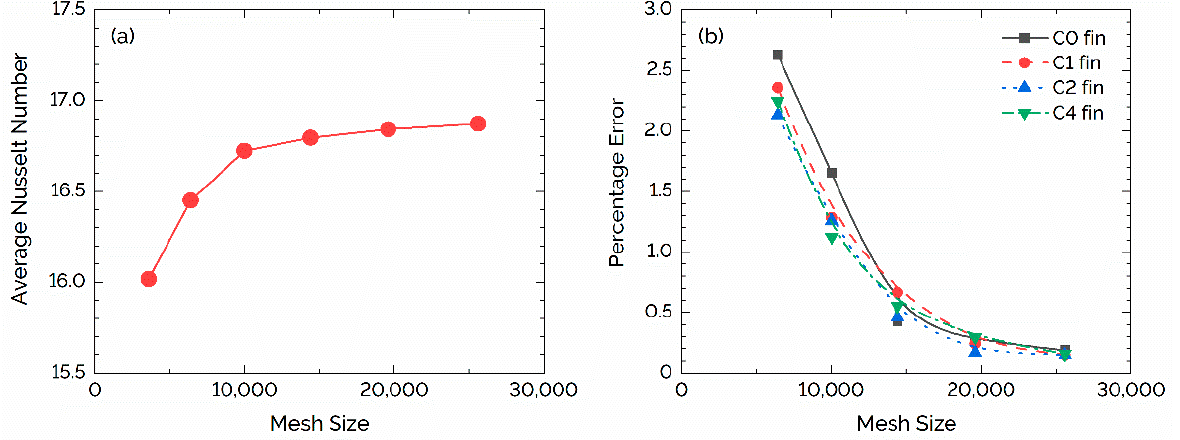
Figure 3. ( a ) The results of the mesh test for the C1 fin with Ra = 10 5 and Re = 10 3 . Here, the number of mesh elements is plotted against the average Nusselt number for each size showing the convergence to the true answer as the mesh becomes finer. ( b ) The percentage error in each mesh size for each fin geometry (as shown in Figure 2).